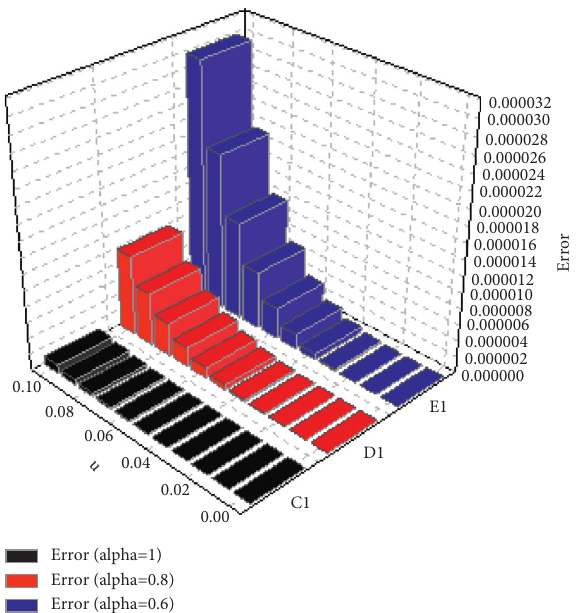
Figure 3: The graph of the absolute error at various fractional orders for problem